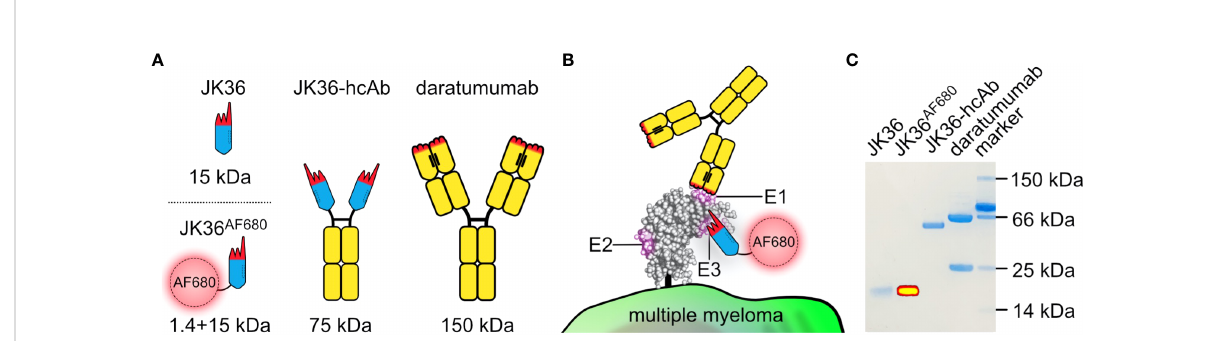
FIGURE 1 Structure, binding sites, and purity of JK36 AF680 nanobody, JK36 heavy chain antibody, and daratumumab. (A) Comparison of different antibody constructs targeting CD38. The framework of single-domain antibody (nanobody) JK36 is indicated in blue with the CDR-regions indicated in red. Heavy-chain antibody JK36-hcAb consists of two heavy chains each containing nanobody JK36 fused to the hinge (black), CH2, and CH3 domains (yellow) of human IgG1. The conventional human IgG1 mAb daratumumab is also indicated in black and yellow. The hydrophobic interface between the two variable domains of daratumumab is replaced by a corresponding hydrophilic region in JK36, accounting for the excellent solubility of this VHH domain in absence of a light chain. (B) Daratumumab (epitope E1) and JK36 AF680 (epitope E3) recognize two distinct, non-overlapping epitopes (E1 and E3) of CD38. Epitope 2 (E2) is recognized by nanobody JK2 (not shown) and was used in our study for control staining of CD38. (C) 1 µg of puri fi ed JK36 AF680 , JK36-hcAb, and daratumumab were size-fractionated by SDS-PAGE and visualized by Coomassie staining. Superimposed fl uorescent signals (yellow) were recorded using a near-infrared fl uorescence in vivo imaging